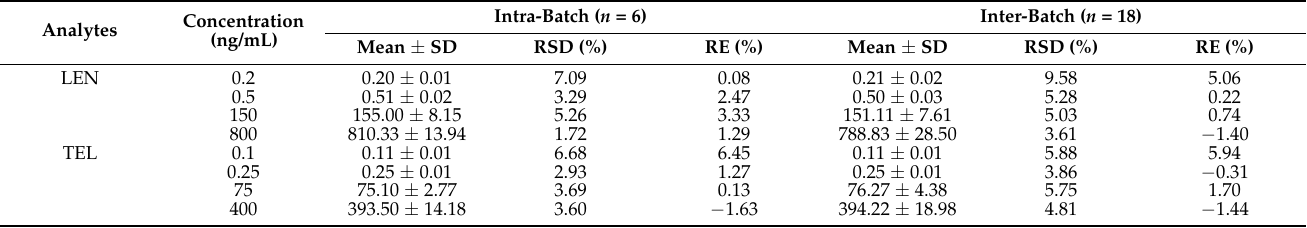
Table 1. Intra-batch and inter-batch precision and accuracy of LEN and TEL in rat plasma.